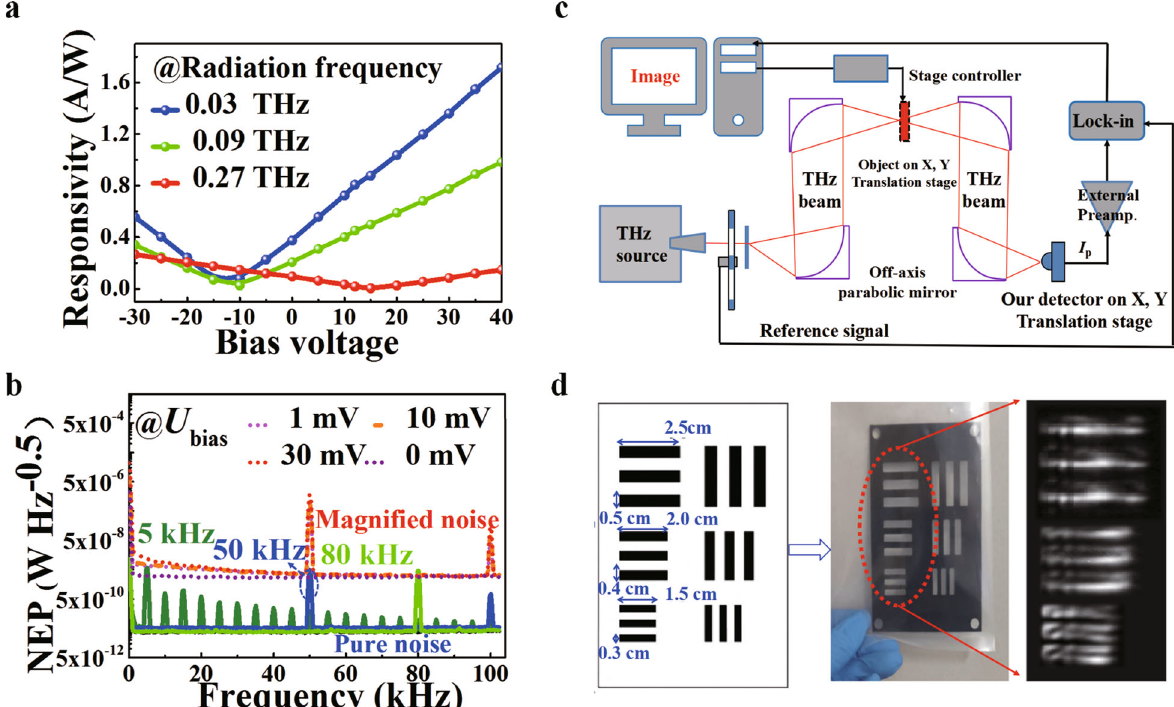
Fig. 4 Performance evaluation of EuSn 2 As 2 -based THz detectors. a Current responsivity as a function of bias voltage; input power P in ~ P density × S antenna ; here, S antenna = π R 2 ~ 0.13 mm 2 is the whole area of the antenna, and P density is the power density reaching the detector. b NEP of the detector under the without/with modulated radiation (5 kHz, 50 kHz, and 80 kHz) and bias voltages (0 mV, 1 mV, 10 mV and 30 mV). The pure noise of a single device is indicated using the solid line ( U bias = 0 mV), and the magni fi ed noise (>100 times) of single device and test system is indicated using the dotted line. c Schemati c of transmission-mode THz imaging for macroscopic objects. d Image of a scale plate scanned at 0.27 THz in the single-pixel transmission